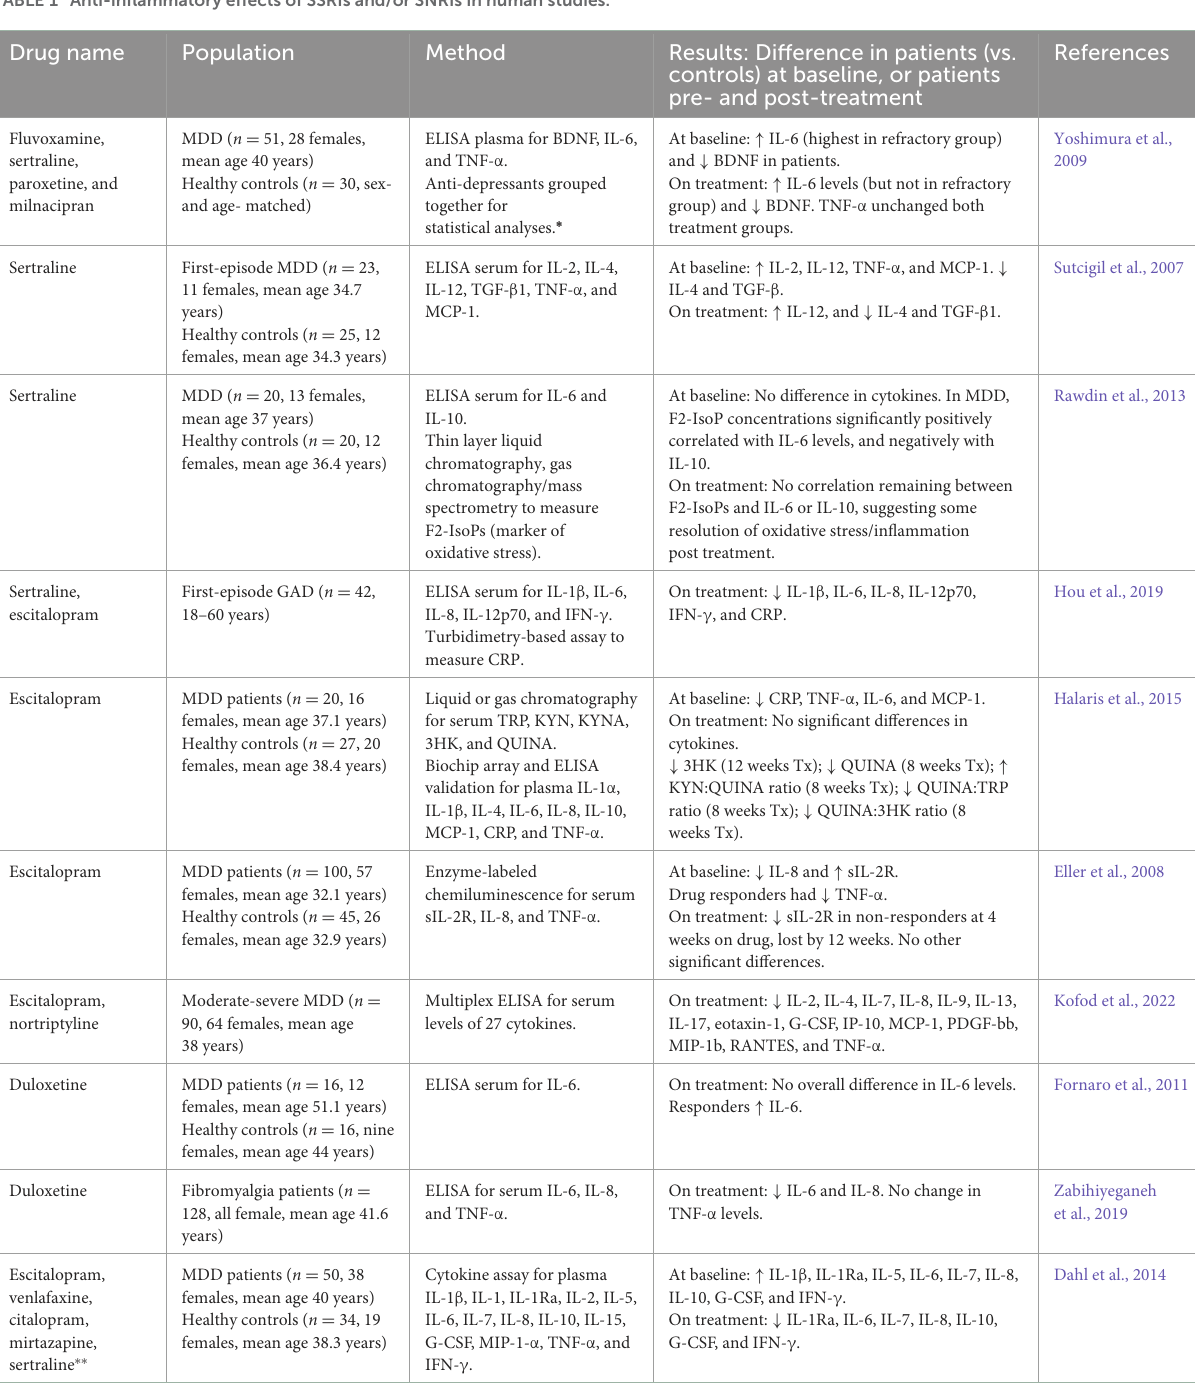
TABLE 1 Anti-inflammatory effects of SSRIs and/or SNRIs in human